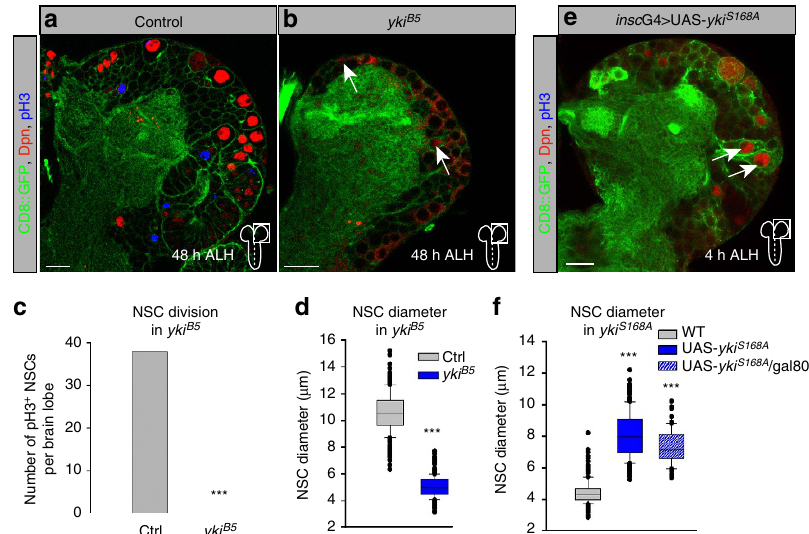
Figure 3 | Yorkie is necessary and sufficient for NSCs growth and proliferation. ( a , b ) NSC growth and proliferation is impaired in yki B5 deletion mutants ( b ) compared with wild-type NSCs at 48h ALH ( a ). ( c ) Average number of NSCs in mitosis (pH3-positive) at 48h ALH in wild-type and yki B5 deletion mutants. ( d ) Quantification of NSC cell diameters yki B5 deletion mutants at 48h ALH. *** P o 0.001. Wilcoxon rank sum test. Median and s.d. were calculated from two biological replicates. Control n ¼ 240 NSCs (5 brain lobes); yki B5 , n ¼ 459 NSCs (10 brain lobes). ( e ) Expression of ykiS168A in NSCs is sufficient to reactivate NSCs 4h ALH. ( f ) Quantification of NSC cell diameters in ectopic expression of insc G4 4 ykiS168A (blue) or larval-restricted expression using the GAL80ts system (blue with white lines) at 4h ALH. *** P o 0.001. Wilcoxon rank sum test. Median and s.d. were calculated from two biological replicates. Control n ¼ 150 NSCs (3 brain lobes); insc G4 4 ykiS168A, n ¼ 200 NSCs (4 brain lobes); insc G4 4 ykiS168A ; tub P GAL80ts, n ¼ 62 NSCs (4 brain lobes). All images are single focal planes, anterior up. Scale bar, 10 m